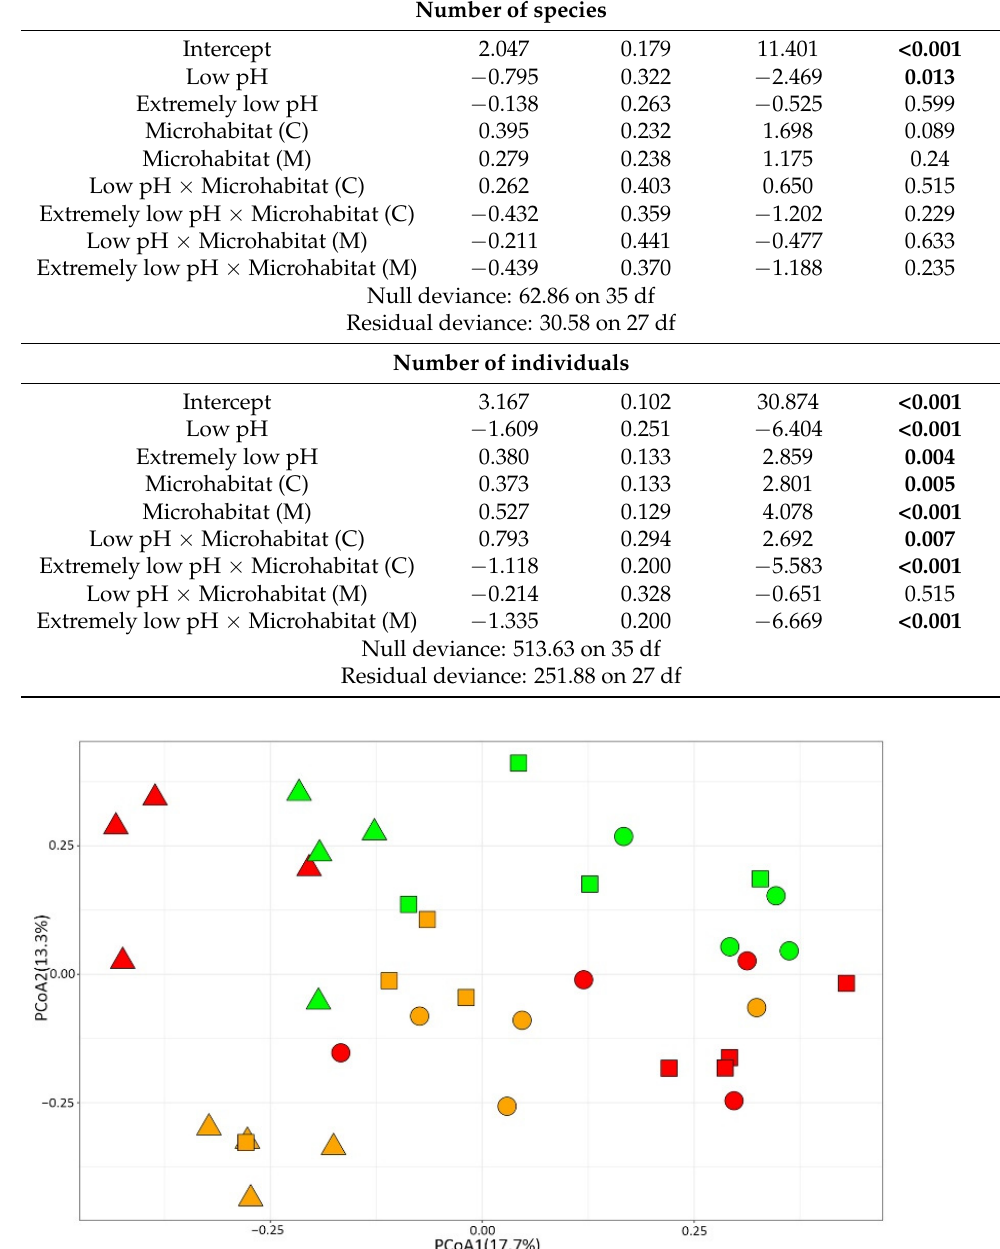
4. Discussion Ocean acidification modifies the structure and composition of marine benthic communities; these aspects and processes can be addressed in studying naturally acidified systems, such as CO 2 vents. Although vents are not perfect predictors of changes that will occur at larger scale in future oceans, they provide information of the possible effects on local marine communities [61], otherwise impossible to achieve through mesocosms or Free Ocean Carbon Dioxide Enrichment (FOCE) systems [62]. Vents acidify surrounding waters and, as open systems, allow habitat connectivity through natural larval exchange, allowing researchers to study ecosystem processes, such as benthic community dynamics and changes under OA conditions [9]. In the three systems studied here (Castello north and south, and Vullatura), the pH exhibited wide daily fluctuations, especially at low and extremely low pH stations. This variability reflects local conditions at a small–medium spatial scale and in time ([15] and references therein), influenced by hydrodynamics, vents emissions, and biological activity (i.e., photosynthesis and respiration rates). Our results show that settlement of mollusc taxa in P. oceanica meadows subjected to OA is highly influenced by the decrease of seawater pH at the three vents systems studied, although some species are less affected by these environmental conditions. Furthermore, this study highlights the role of P. oceanica meadows as a nursery area, buffering the effects of OA on the associated biota. Posidonia oceanica leaf length showed significant variations among pH conditions, with lower values reported for low and extremely low pH stations. This pattern can be linked to the greater vulnerability of the seagrass under acidified conditions, due to the